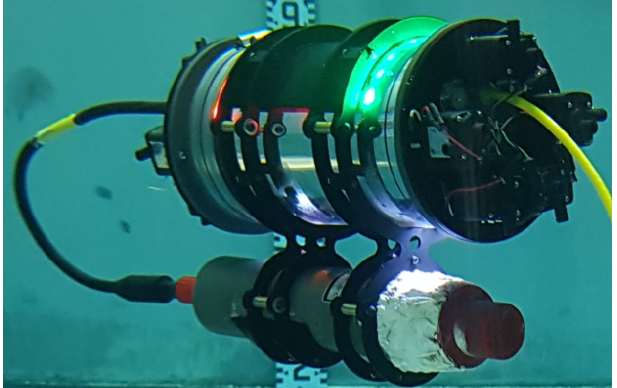
Figure 3. Mounting of the IMAGENEX 831l sonar beneath the AVEXIS TM